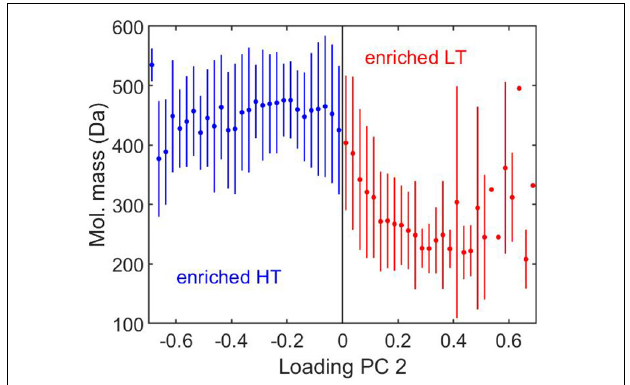
FIGURE 4 | Average ± 1 standard deviation of molecular mass as a function of the loading of PC 2 shown in Figure 3C . Positive loadings (shown in red) represent molecular formulae enriched in samples collected at low tide (LT), while negative loadings (shown in blue) represent formulae enriched in samples collected at high tide